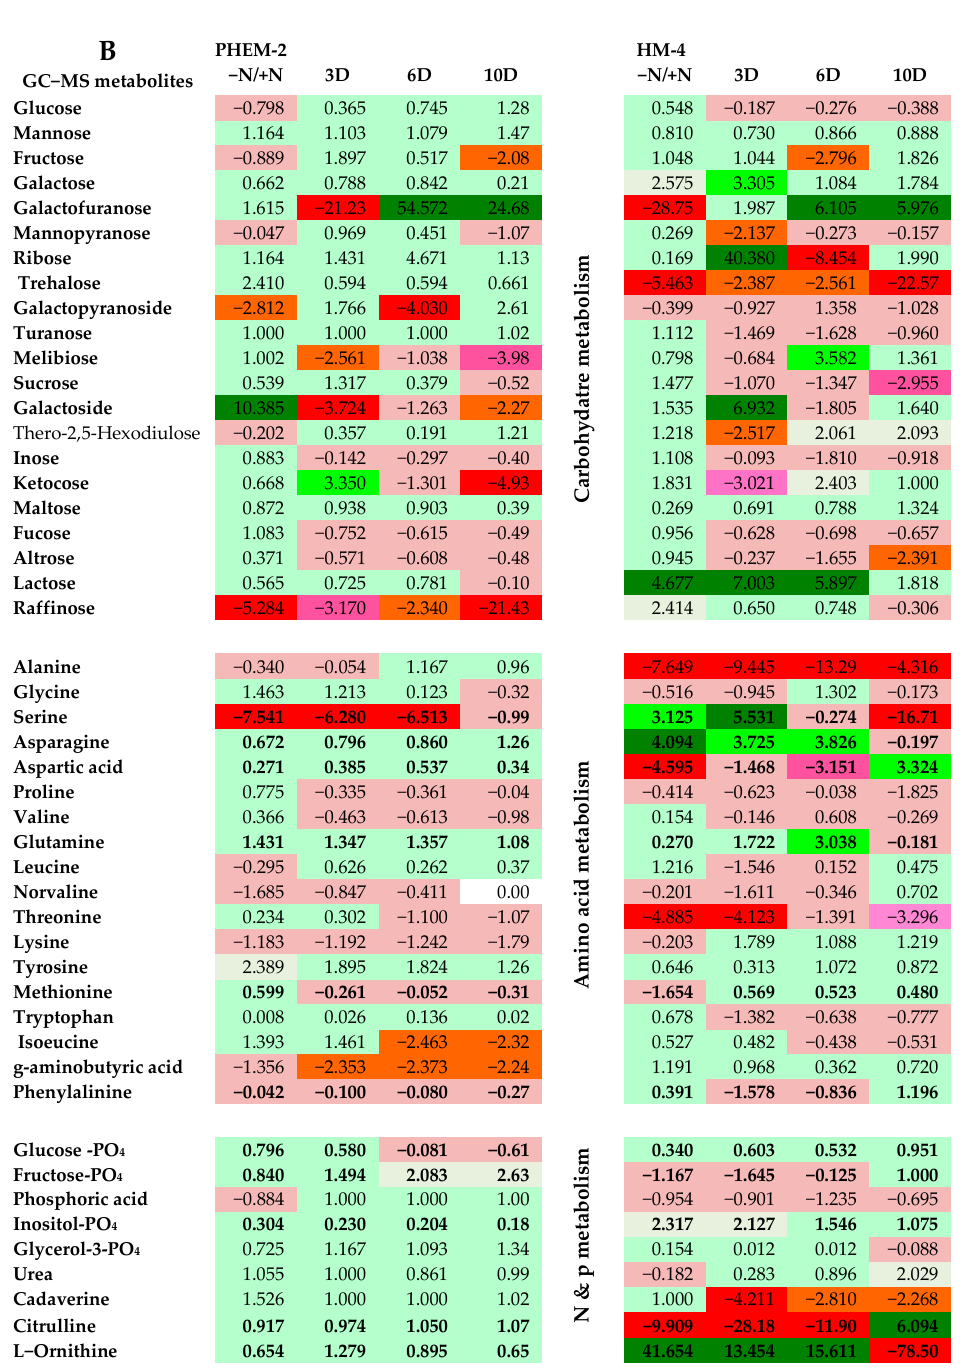
Figure 2. Metabolic responses to N deficiency of low-N tolerant (LNT; PEHM-2) and low-N sensitive (LNS; HM-4) genotypes. ( A ) Root metabolites and ( B ) leaf metabolites. The calculated data shown above exhibit a log transformed fold change (0.05 mM/4.5 mM N) of selected metabolites detected by GC–MS in low-N (0.05 mM), sufficient-N (4.5 mM) and recovery (3DR, 6DR and 10DR) samples. The level of significance between sufficient-N (4.5 mM) and low-N (0.05 mM) treatments was tested by the Student’s t -test ( p -value < 0.05). Significantly changed metabolites in various groups are represented in bolded form. Upregulation and downregulation of metabolites are indicated with the help of color bar scale, upregulated (green) or downregulated (red), in metabolite logarithmic fold change, as indicated in the color index ( n = 6).